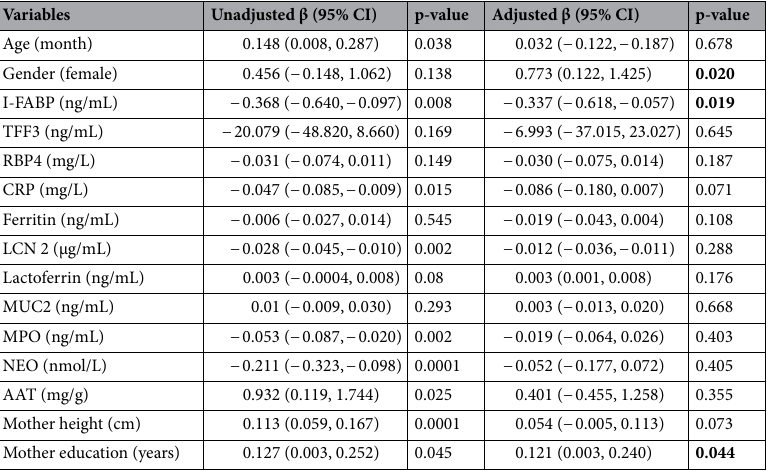
Table 4. Multivariable linear regression analysis to see the association of other variables with LAZ. Significant values are in bold.